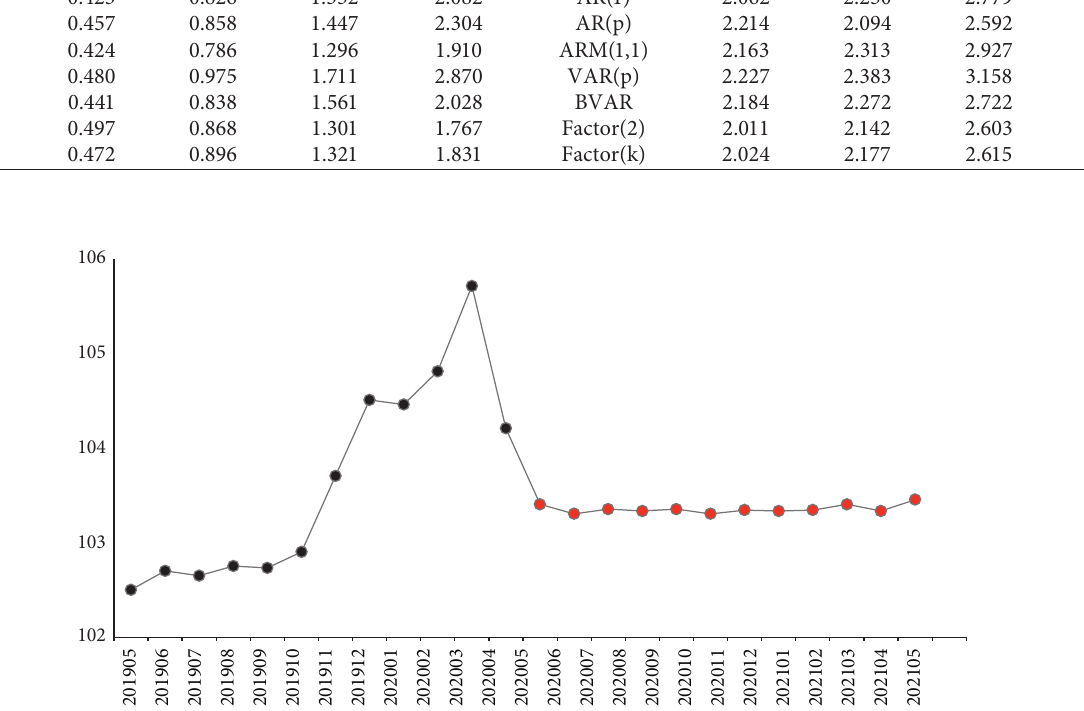
Figure 4: CPI forecast value for 12